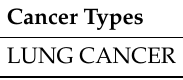
Table 1. List of patients with lung cancer, other cancers, and control subjects. Cancer